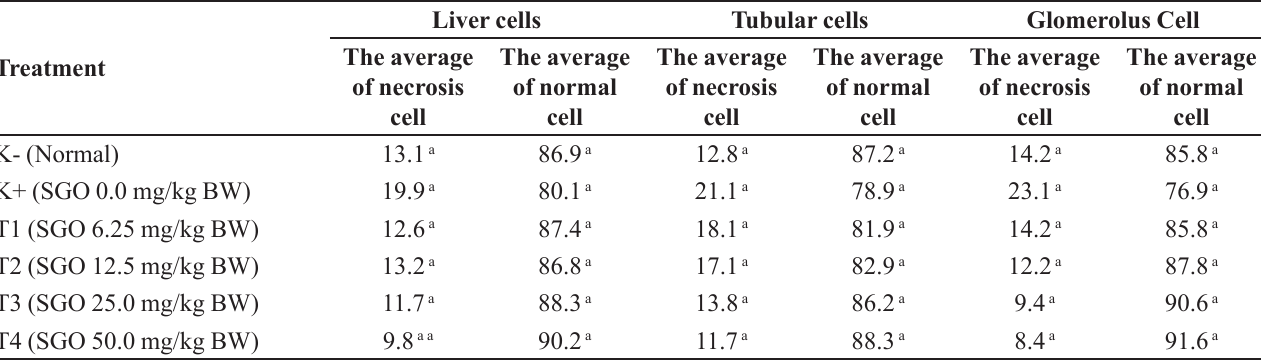
TABLE III - The average number of necrosis cells in mice treated with single-garlic oil extract with various concentration